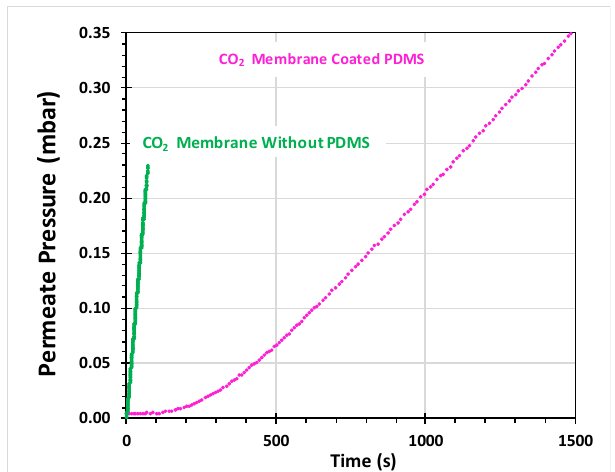
Figure 6. Example of CO 2 pure gas permeation curves at 25 °C and 1 bar feed pressure of membrane PEEK-WC/ m -xy with and without silicone coating, showing the effective healing of pinhole defects by the flat baseline (dashed line).